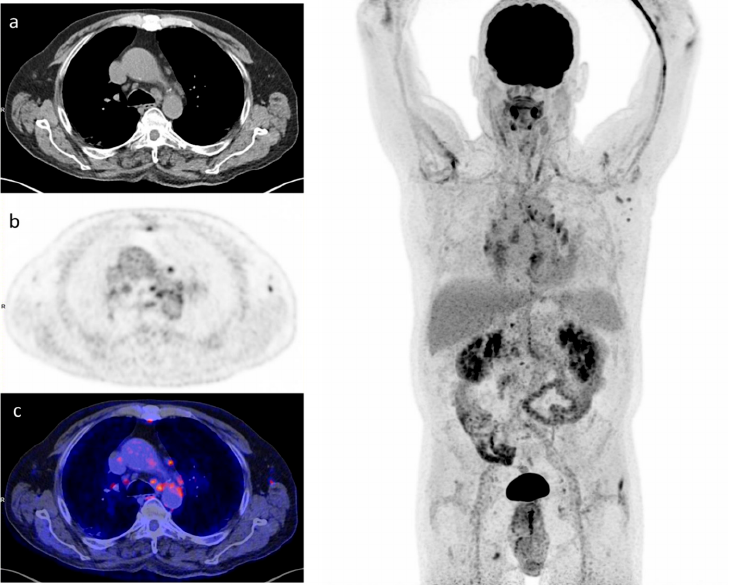
Figure 1. A 64-year man admitted for multilobar pneumonia caused by SARS-CoV-2. The [ 18 F]FDG- PET/CT at 3 months after symptom onset shows increased [ 18 F]FDG uptake in residual pulmonary lesions (TLG 124,11) and mediastinum lymph node (SUVpeak 1,73). Pulmonary function tests evi- denced severe pulmonary diffusion impairment, with a diffusing capacity of the lungs for carbon monoxide 41% of the predicted value. Left: ( a ) CT transverse slice, ( b ) [ 18 F]FDG-PET slice, and ( c ) fused [ 18 F]FDG-PET and CT images. Right: whole-body, maximal intensity projection image, dis- playing mediastinal lymph nodes with [ 18 F]FDG uptake . Patients with positive and negative [ 18 F]FDG-PET/CT results significantly differed in age (59.82 ± 8.52 vs. 51.00 ± 8.09 years, respectively, p = 0.03), Charlson index score ≥ 1 (66.7 vs. 100%, p = 0.038), presence of fatigue (90.9 vs. 44.4%, p = 0.024) and respiratory distress (90.9 vs. 44.4%, p = 0.024), hemoglobin levels (13.41 ± 1.91 vs. 15.24 ± 1.58 g/dL, p = 0.041), and lymphocyte count (1.78 ± 0.53 vs. 2.47 ± 0.49 × 10 3 /µL, p = 0.011) at 2–3 months post- discharge (Figure 2).